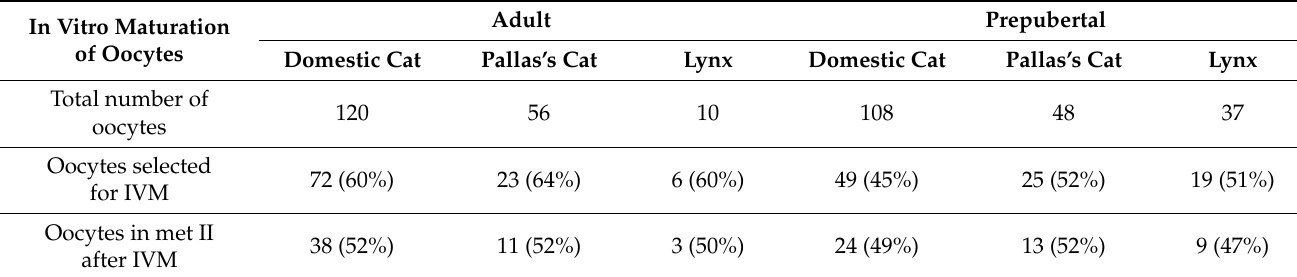
Table 3. Results of in vitro fertilization (IVF) of oocytes obtained from prepubertal and adult domestic cats.